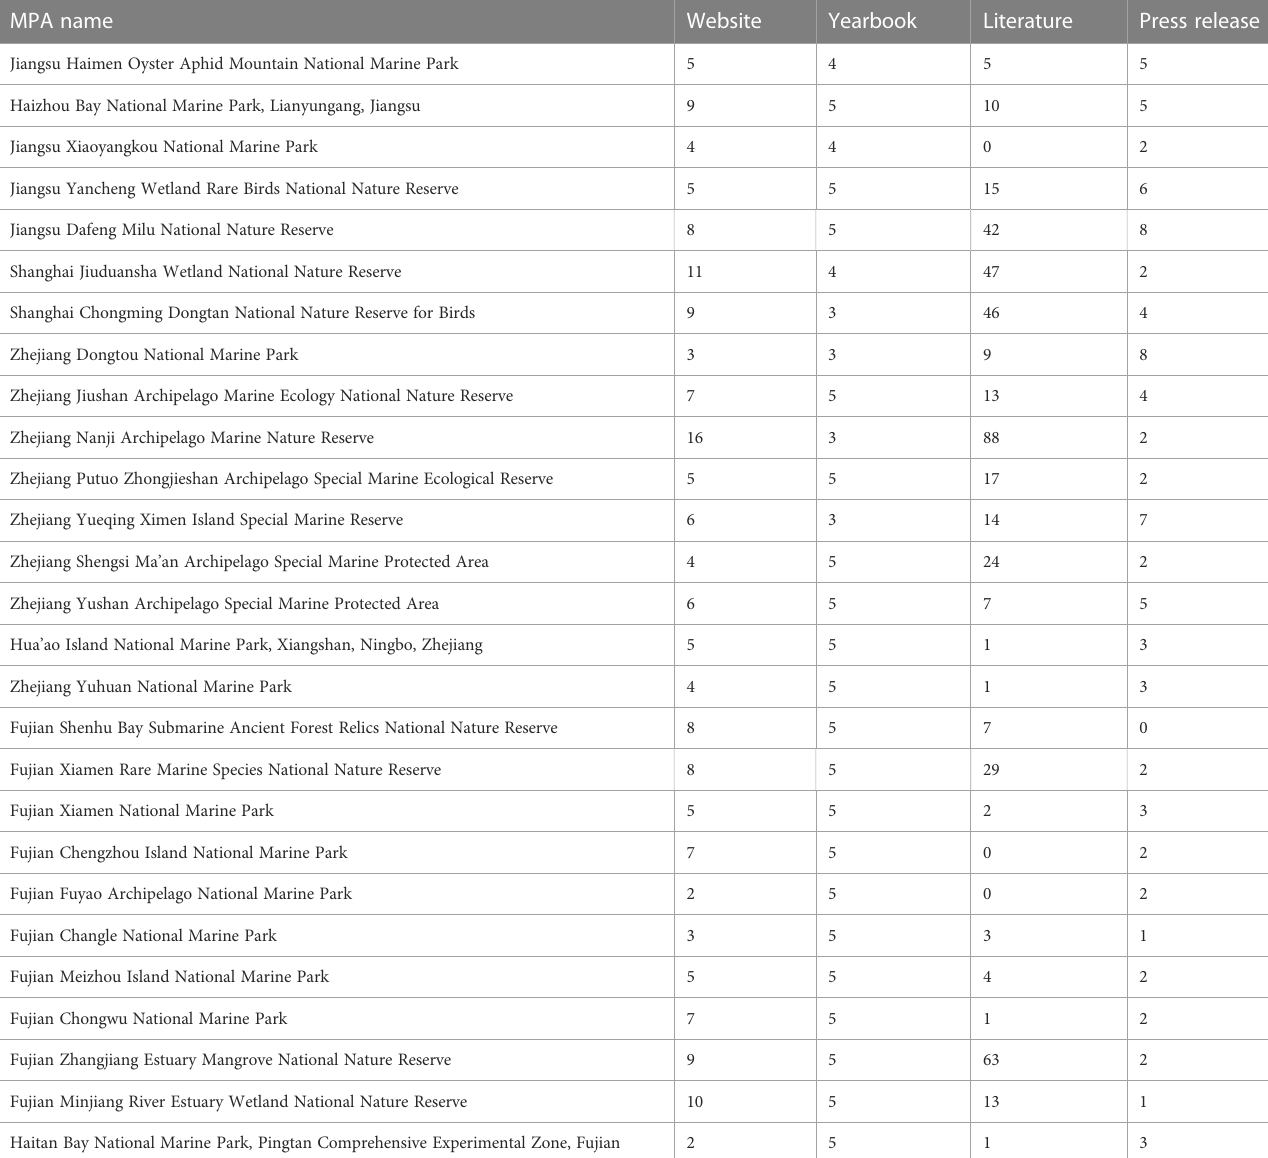
TABLE 4 Data sources for each protected